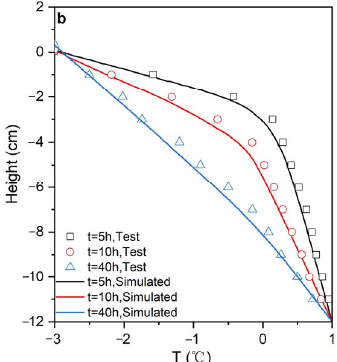
Figure 6. Comparison between the measured and simulated ground temperature values at the 1 m